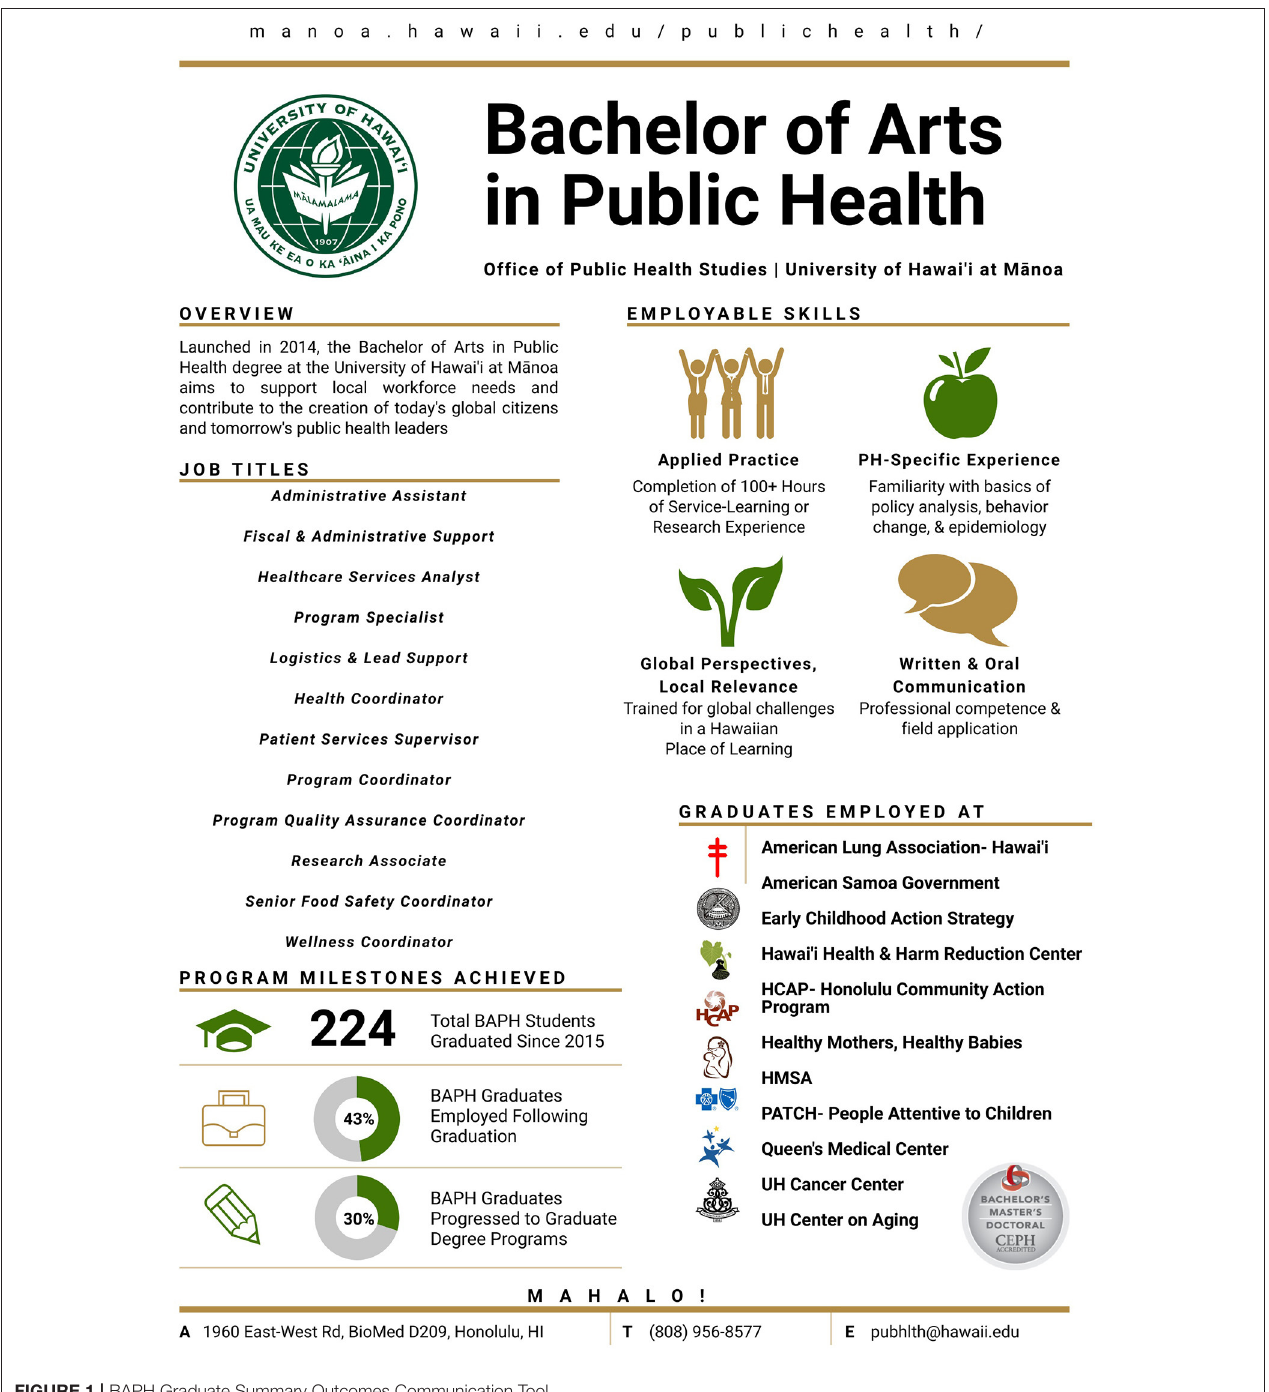
FIGURE 1 | BAPH Graduate Summary Outcomes Communication